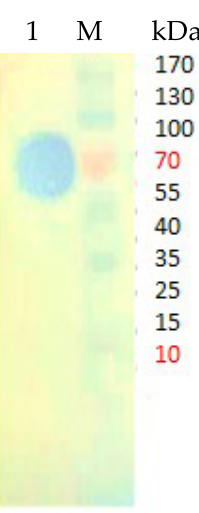
Figure 3. ( a ) Analysis of purified product on SDS-PAGE of LSK25 lipase. Lane 1: Refolded crude enzyme, Lane 2: Purified lipase LSK25 lipase via Ni-Sepharose affinity chromatography (65 kDa), Lane M: Standard protein marker. ( b ) native-PAGE analysis of the purified lipase LSK25.